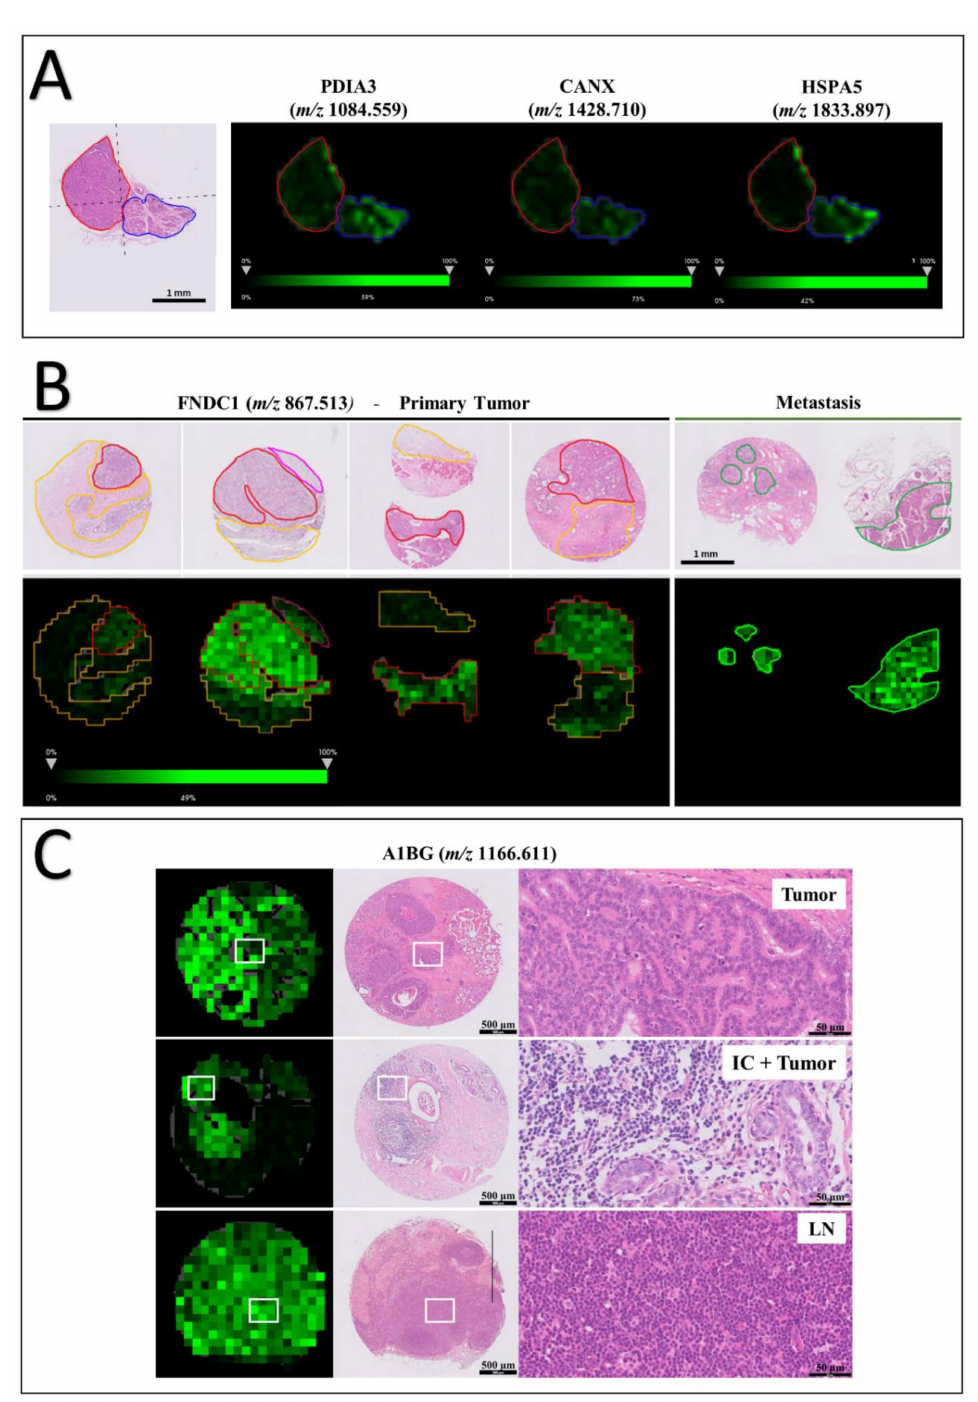
Figure 3. MSI data of canine samples. ( A ) WD (blue line) and PD (red line) tissue distribution of m/z signals assigned to proteins enriched in protein folding in endoplasmic reticulum, and folding, assembly, and loading of MHC class I pathway: protein disulfide isomerase family A member 3 ( m/z 1084.559), calnexin ( m/z 1215.622) and heat-shock protein family A member 5 ( m/z 2042.051). ( B ) Signal of FNDC1 peptide at m/z 867.513 is strong across primary tumor and metastatic areas. ( C ) A1BG peptide at m/z 1166.611 was found to be expressed not only across primary tumor areas but also by inflammatory cells (IC) in canine samples. Corresponding HE staining shows signal distribution in tumor cells, tumor areas with infiltrating inflammatory cells, and across the lymph node